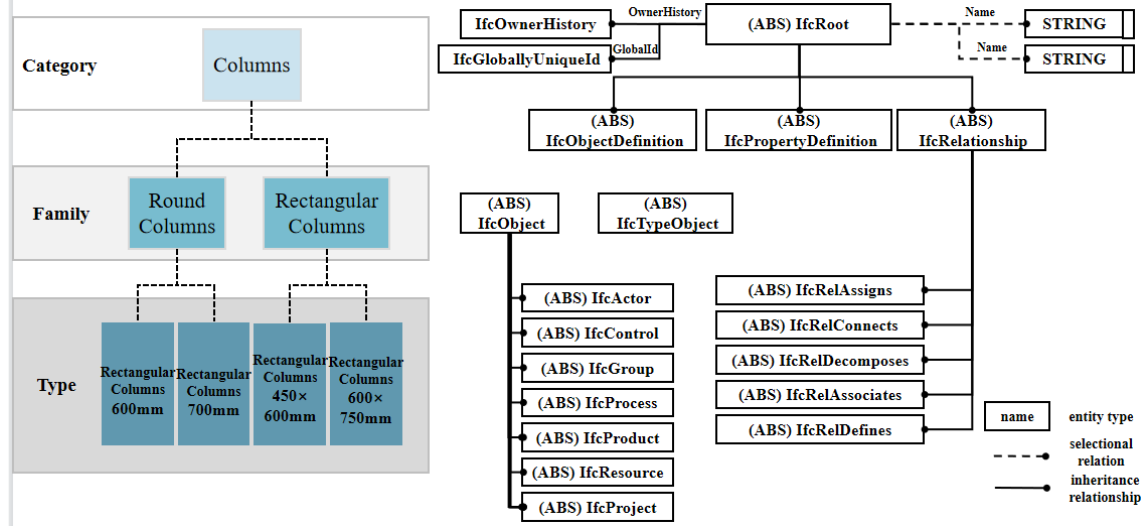
Figure 1. The organization of information in a three-dimensional database of Revit API ( left ) and IFC documentation ( right ).